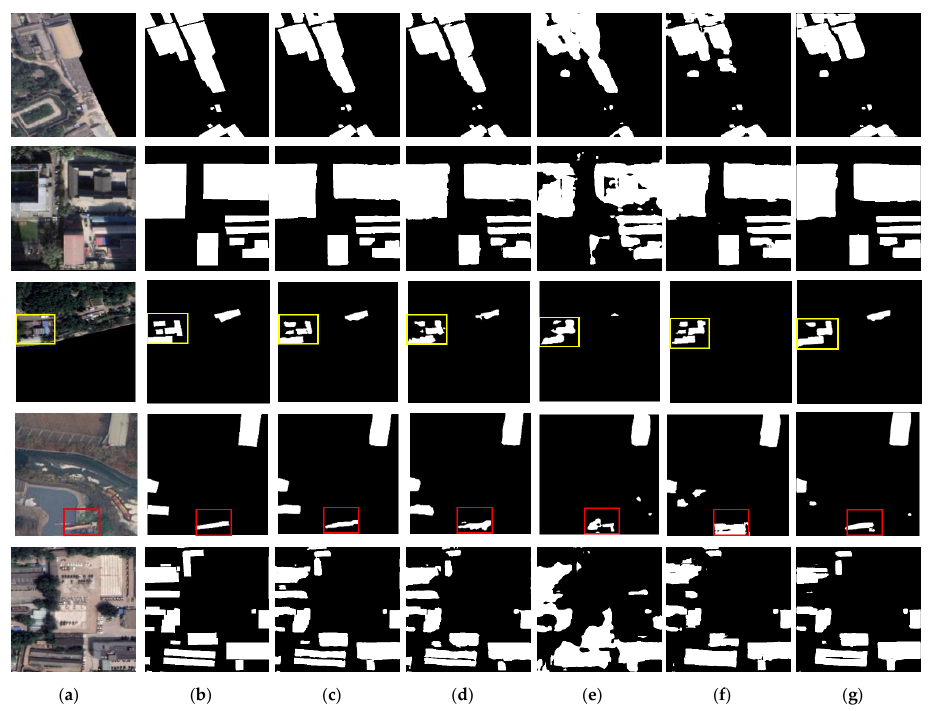
Figure 10. Partial details of the building in the emergency shelter through different methods. ( a ) Original image. ( b ) Ground truth. ( c ) EfficientUNet+. ( d ) DeepLabv3+. ( e ) PSPNet. ( f ) ResUNet. ( g )